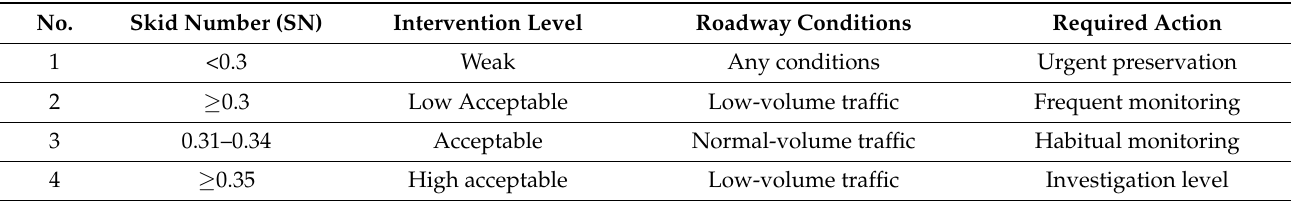
Table 7. Standard skid number (SN), intervention level, and actions based on a commonly used device (SCRIM) (adapted from